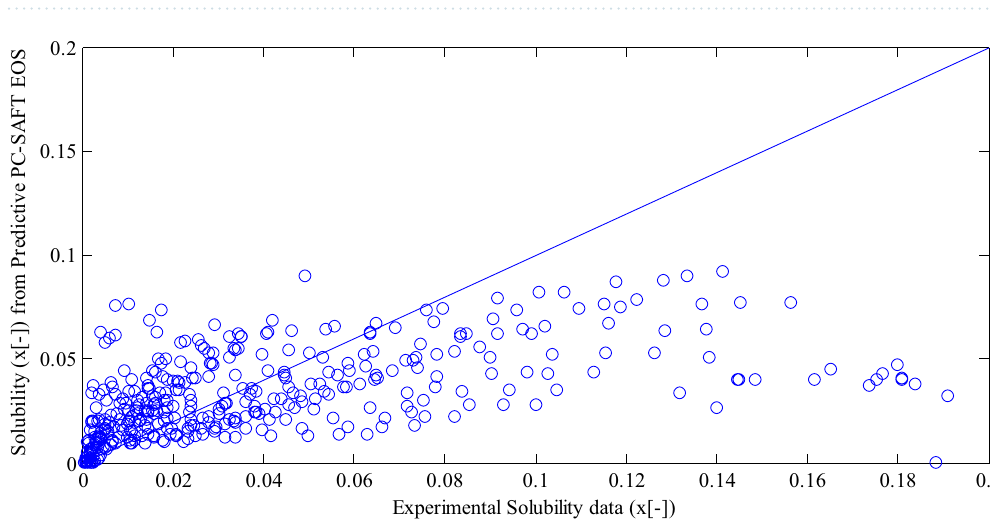
Figure 8. Calculated solubilities from the predictive PC-SAFT EOS (solid lines) for dapsone in pure acetone, methyl acetate, and methanol with the optimized binary interaction parameters -0.0455, 0.0156, and 0.0758, respectively, versus the experimental data of solubility for dapsone in pure acetone (circle), methyl acetate (triangular), and methanol (square) 41 .